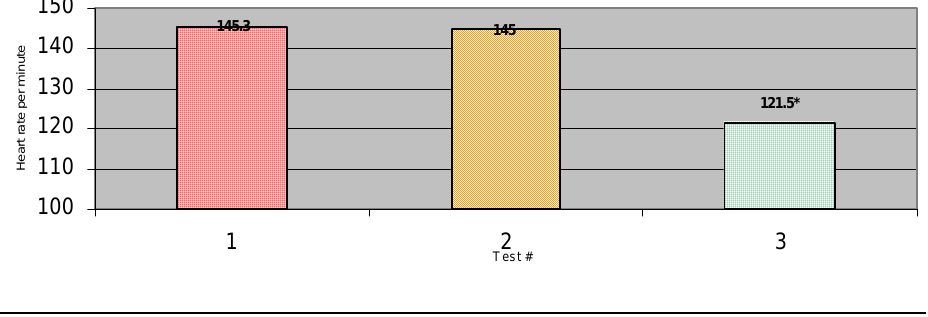
Graph 2. Change in exercise heart rate before and after a treadmill intervention program, all